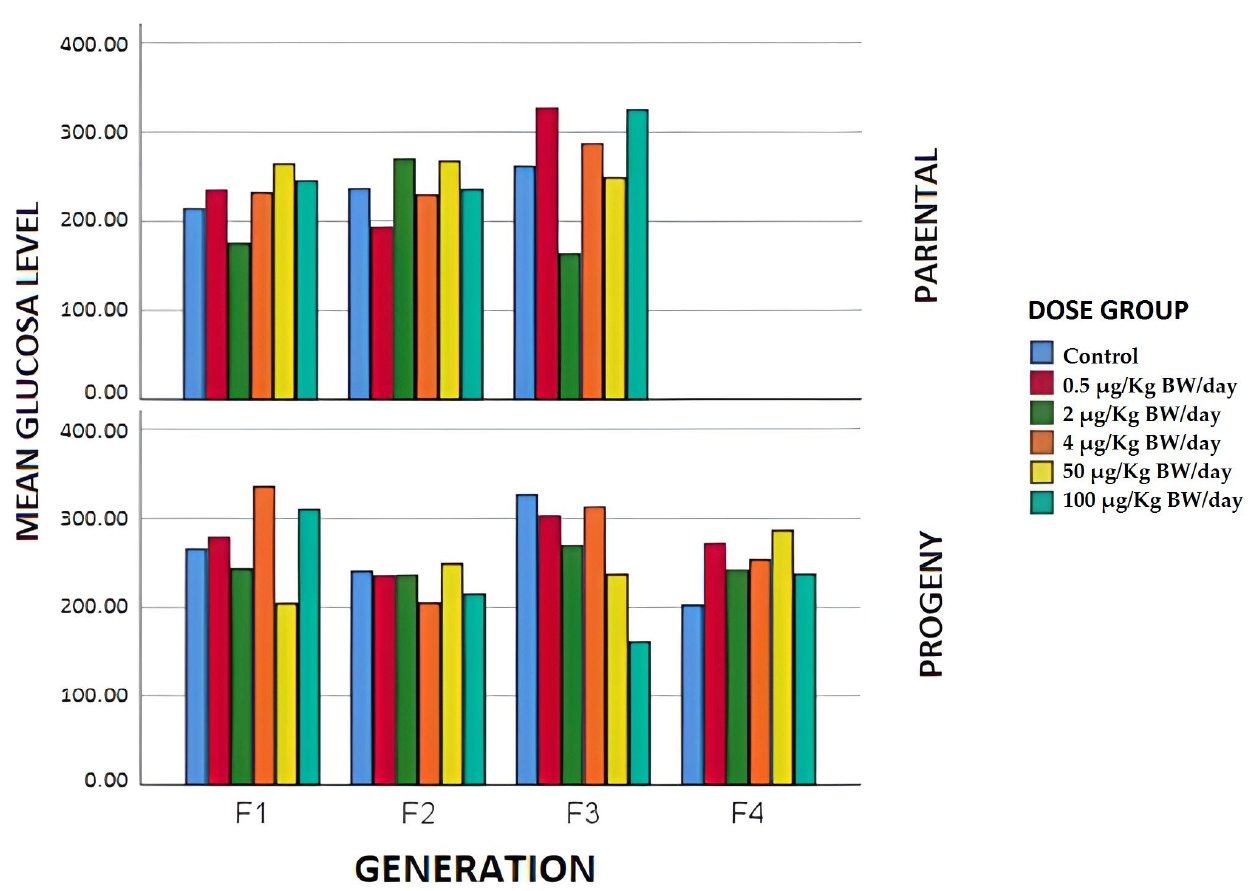
Figure 3. Mean glucose values expressed in mg/dL in the different generations of breeders and offspring in terms of the exposure group.